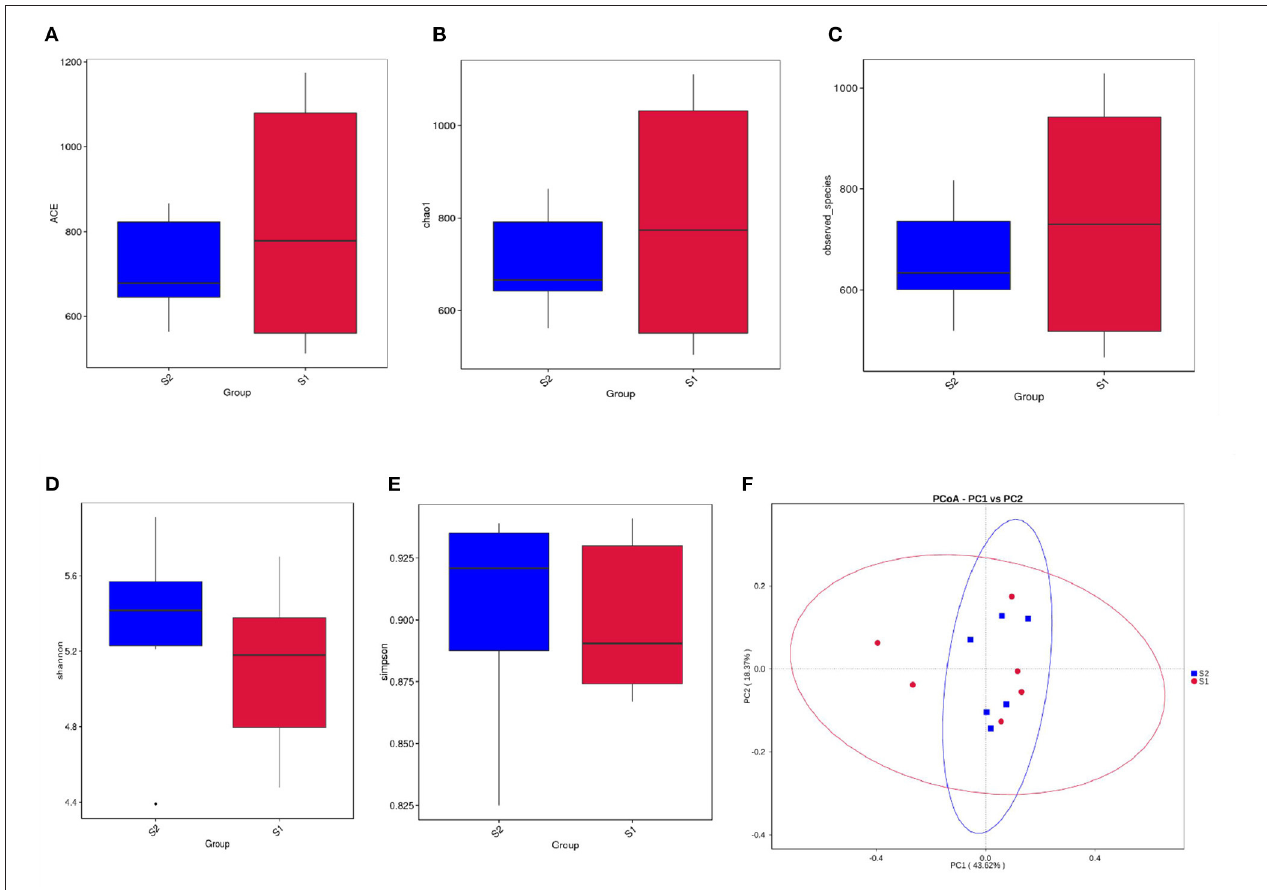
FIGURE 1 | Effects of FWBPs administration on the alpha and beta diversity of the rumen microbiota in lambs. Analysis of the alpha and beta diversity via (A) ACE index, (B) Chao1 index, (C) Observed_species, (D) Shannon index, (E) Simpson index, and (F) principal coordinate analysis (PCoA) of weighted UniFrac distances, respectively. S1, the milk replacer ( n = 6); S2, supplemented with 2 ‰ fermented wheat bran polysaccharides in the milk replacer ( n = 6).